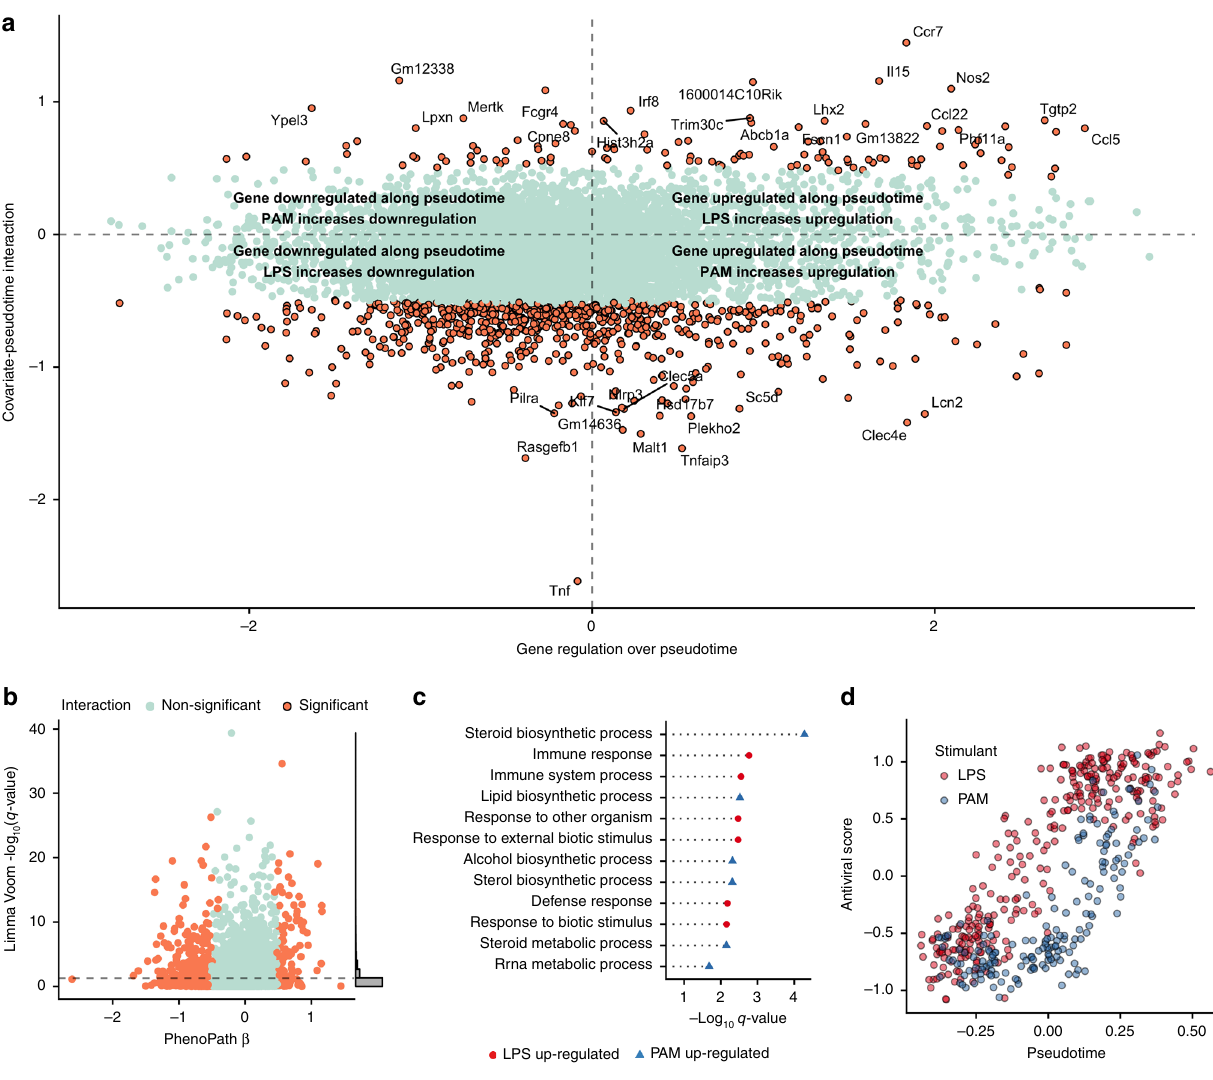
Fig. 3 PhenoPath identi fi es genes differentially modulated over pseudotime using single-cell RNA-sequencing data under perturbation. a PhenoPath applied to the Shalek et al. data set uncovers a landscape of genes differentially regulated along pseudotime depending on the stimulant (LPS or PAM) applied. b A comparison of p -values obtained through a statistical test for differential expression between LPS and PAM stimulation shows no particular relation with the interaction parameters β inferred with PhenoPath. c A GO enrichment analysis of the genes upregulated along pseudotime whose upregulation was increased by LPS stimulation showed enrichment for immune system processes. d Relationship between PhenoPath pseudotime and antiviral score